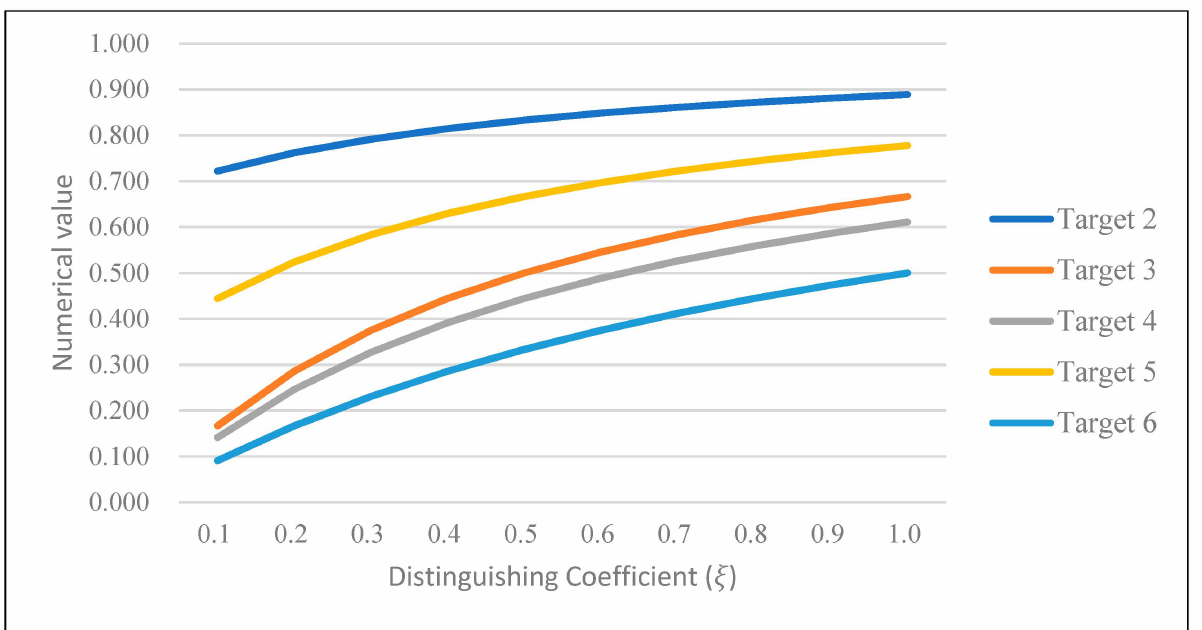
Figure 1. Line chart of GRA analysis results.